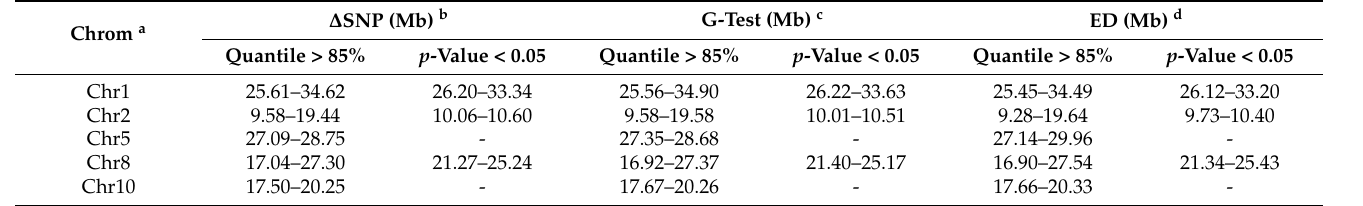
Table 3. QTLs for cold tolerance at the seedling stage in rice identified by different algorithms in PNGseqR.